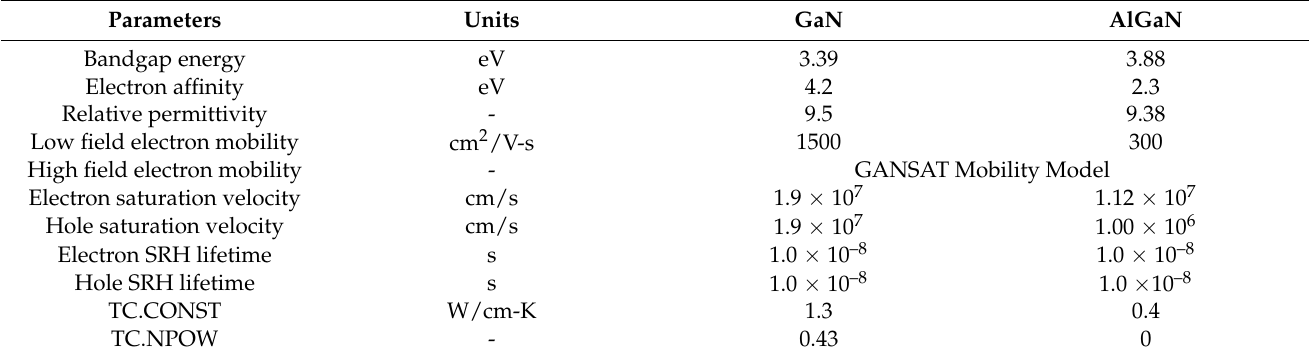
Table 2. Material parameters used for simulation at a temperature of 300 K (SRH: Shockley–Read– Hall).